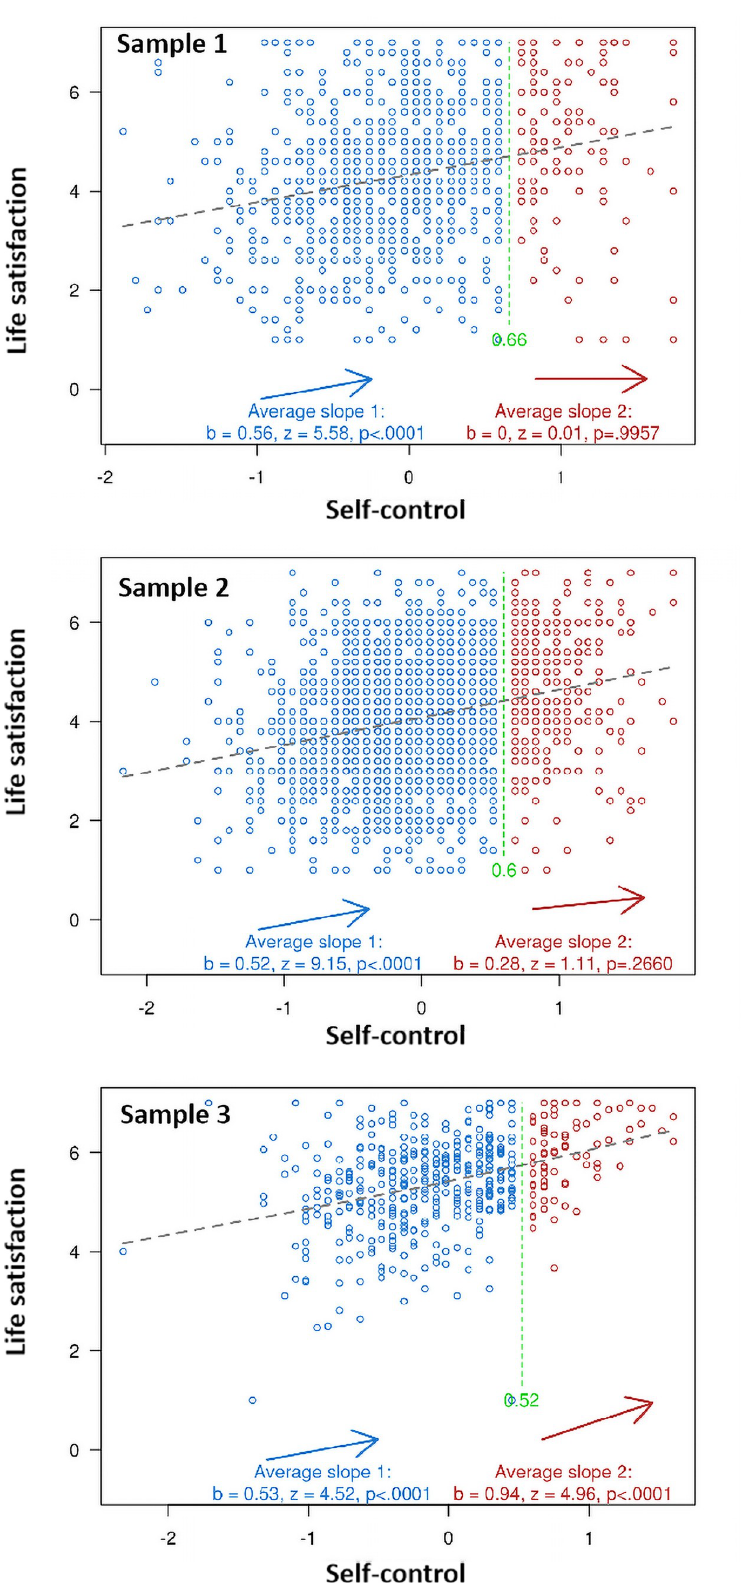
Fig 1. Two-lines test are applied for the relationship between self-control and life satisfaction in three samples. https://doi.org/10.1371/journal.pone.0223169.g001 PLOS ONE | https://doi.org/10.1371/journal.pone.0223169 October 14,